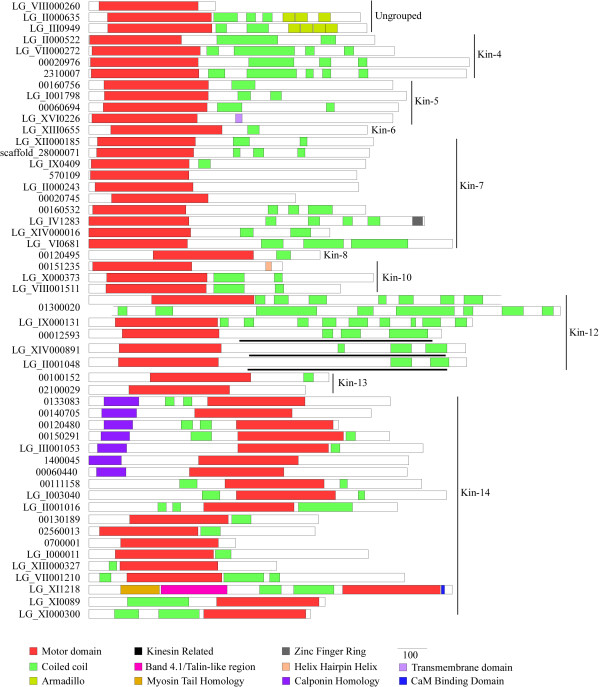
Domain schematics for P. trichocarpa. Schematic diagram showing the domain architecture of kinesins in P. trichocarpa. Family classifications are shown to the right of the proteins.